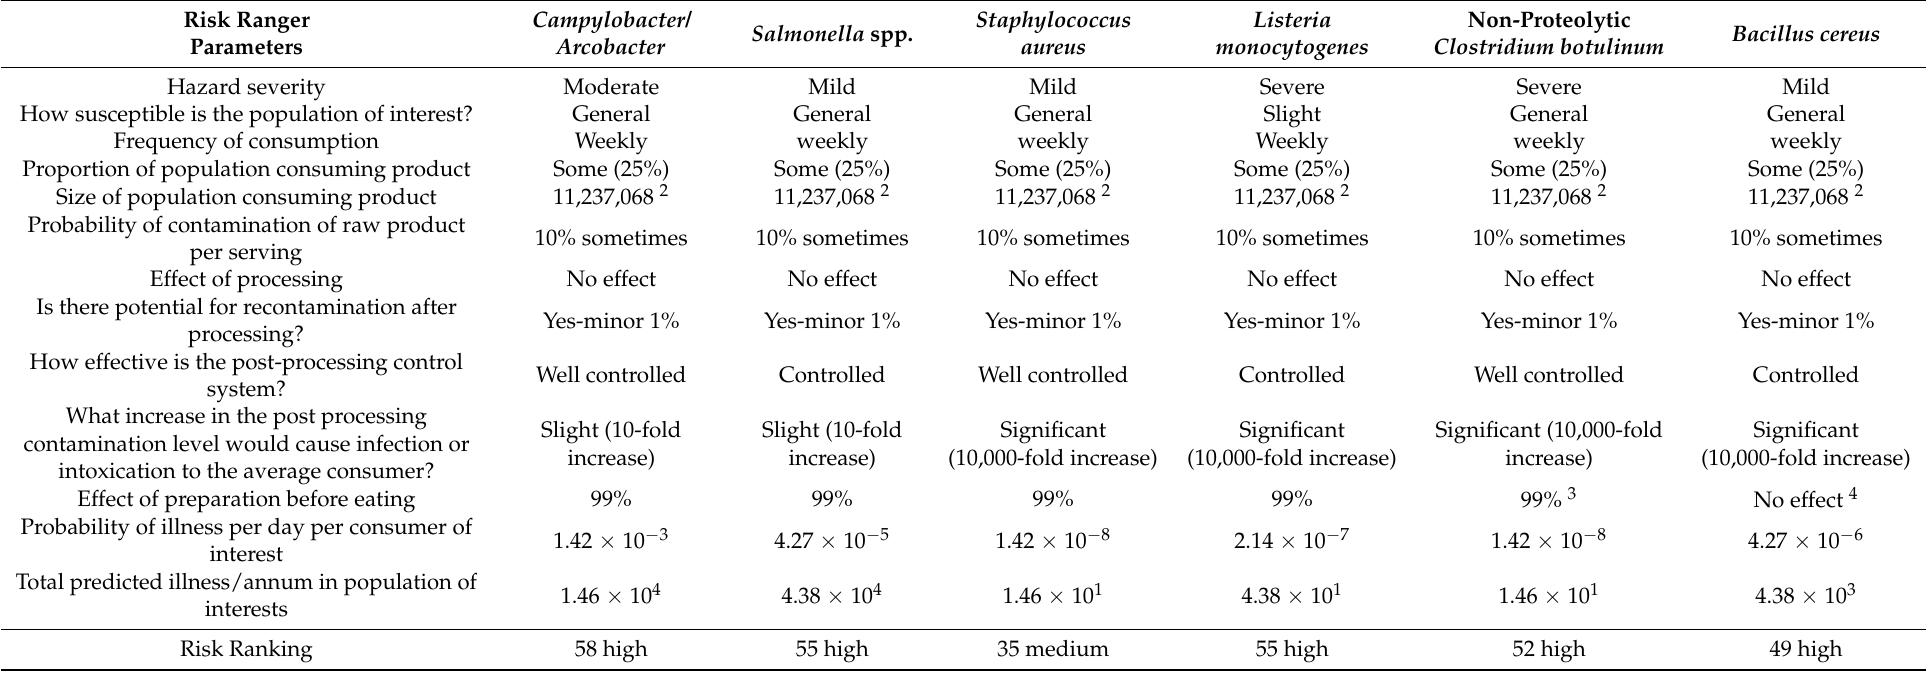
Table 1. Risk Ranger ®1 applied to the RTC